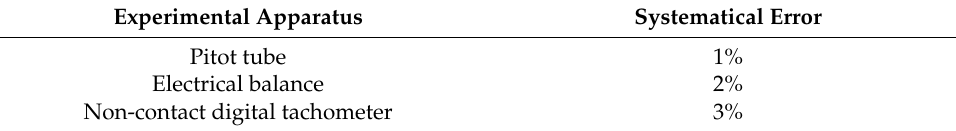
Table 3. Systematical error for the different experimental apparatus.